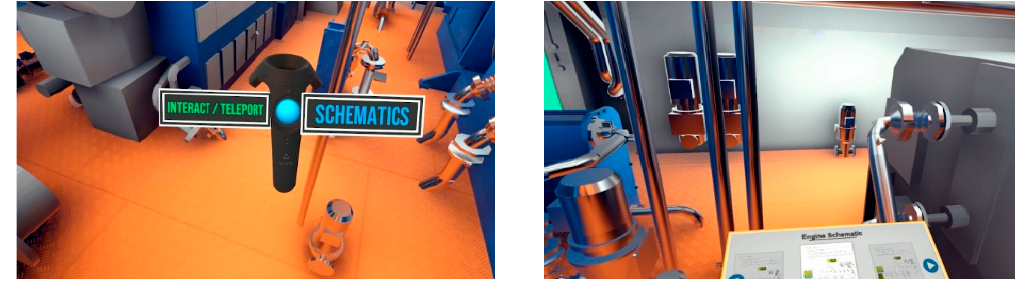
Figure 4. Accessibility to engine and engineer room schematics.